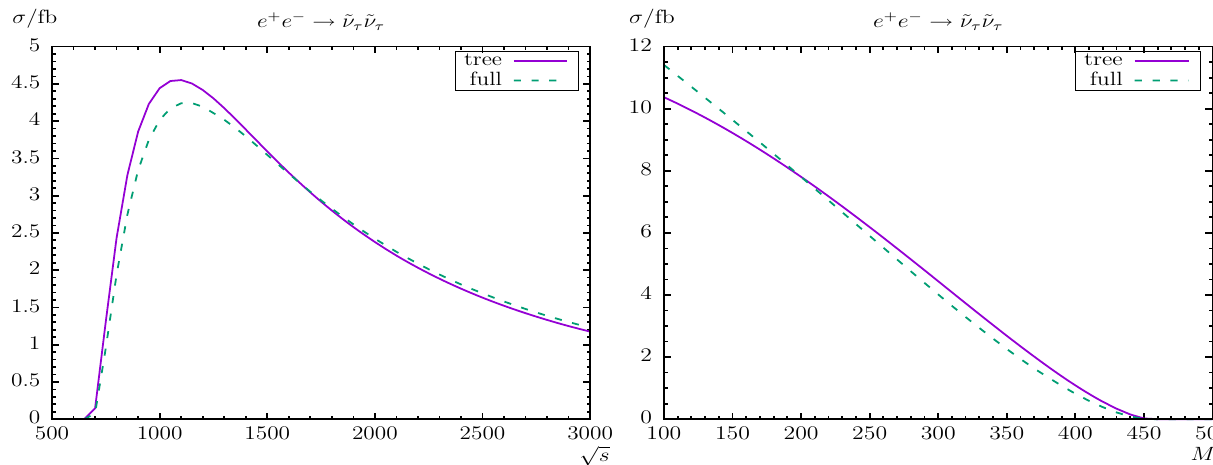
Fig. 20 σ( e + e − → ˜ ν τ ˜ ν ∗ τ ) . Tree-level and full one-loop corrected cross sections are shown with parameters chosen according to S ; see Table 1. √ s (left) and M ˜ The plots show the cross sections with (right) varied. All masses and energies are in GeV E